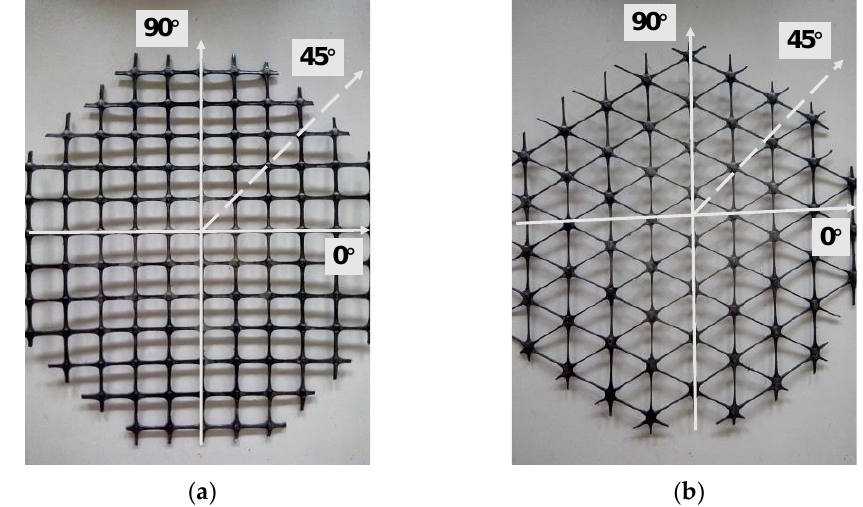
Figure 2. Interface shear test apparatus.